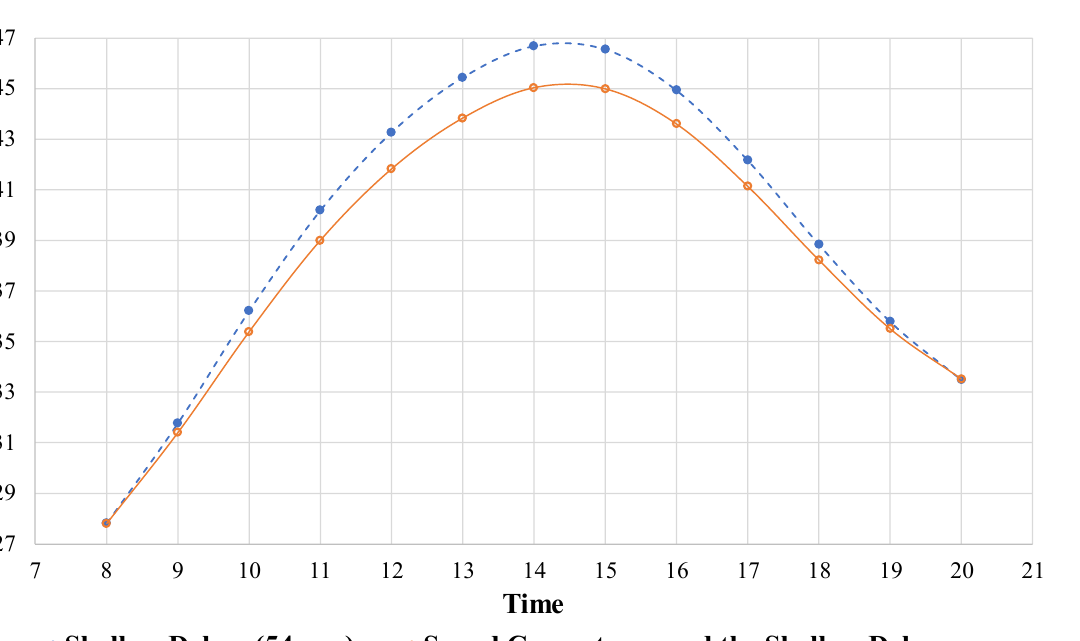
Figure 14. Thermal contrast during a